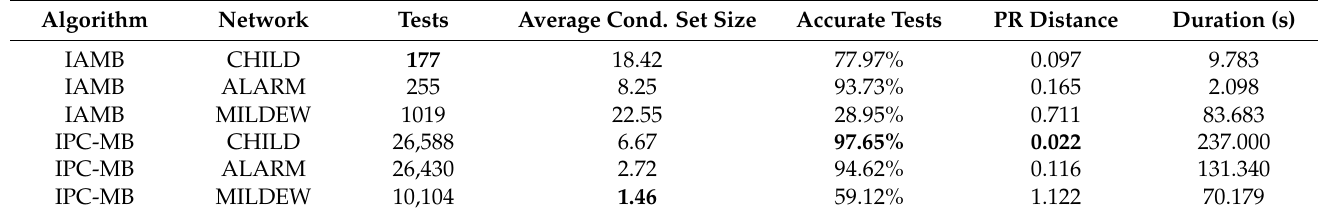
Table 3. G-test results across all datasets of 4000 samples for IAMB and IPC-MB.